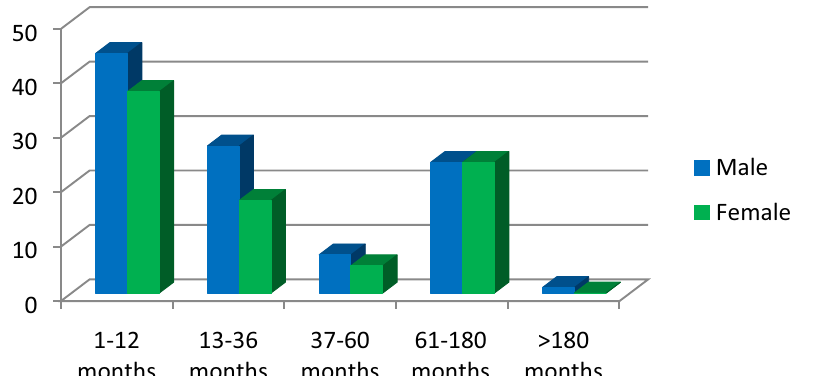
Figure 1. Distribution of participants by age group and gender.